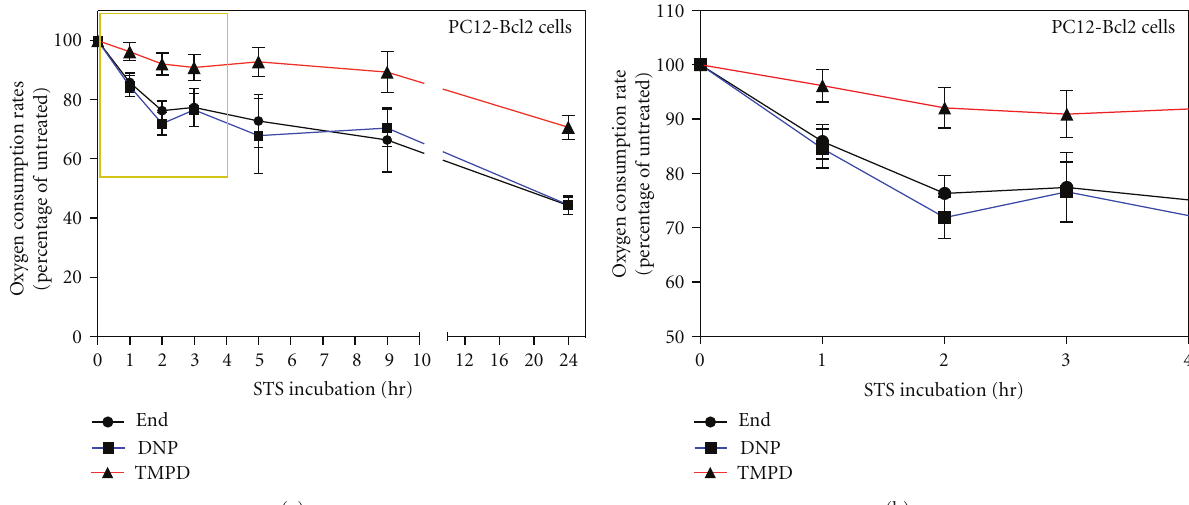
(b) Figure 4: Decrease in endogenous, DNP-uncoupled, and TMPD-dependent respiration rates in intact PC12-Bcl-2 cells treated with STS; early decrease in DNP-uncoupled respiration. (a) Oxygen consumption rates of STS-treated PC12-Bcl-2 cells measured at the indicated time points. Oxygen consumption rates were measured in TD bu ff er (endogenous respiration, End), in TD bu ff er containing DNP (DNP- uncoupled respiration, DNP) and in TD bu ff er containing DNP, antimycin A, ascorbate and TMPD (TMPD-dependent respiration, TMPD). Data are expressed, at each time point, as percentages of the oxygen consumption of untreated cells (0hr). The data represent the means ± SE with n varying at each time point and being 17, 20, 12, 2, 3, 6, 8 respectively for the indicated time points (1h, 2h, 3h, 5h, 9h, 24 h). (b) magnification of (a) area surrounded by a yellow frame. Note that the ordinate scale starts at